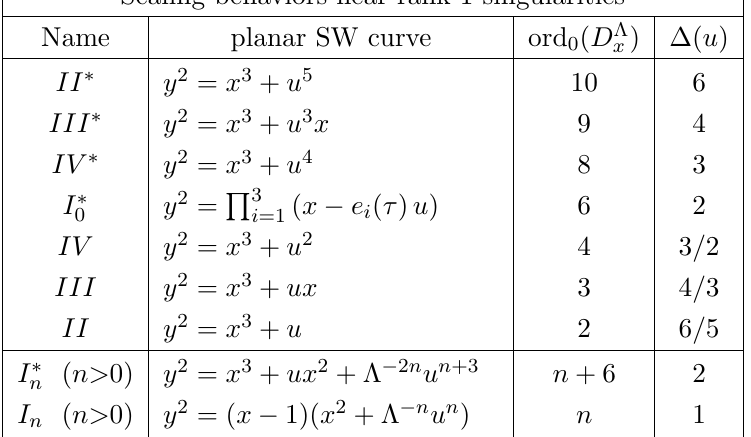
Table 1 . Scaling forms of rank 1 planar special Kahler singularities, labeled by their Kodaira type (column 1), a representative family of elliptic curves with singularity at u = 0 (column 2), order of vanishing of the discriminant of the curve at u = 0 (column 3), mass dimension of u (column 4), a representative of the SL (2 ; Z ) conjugacy class of the monodromy around u = 0 (column 5), the de(cid:12)cit angle of the associated conical geometry (column 6), and the value of the low energy U(1) coupling at the singularity (column 7). The (cid:12)rst seven rows are scale invariant. The last two rows give in(cid:12)nite series of singularities which have a further dimensionful parameter (cid:3) so are not scale invariant; they can be interpreted as IR free theories since (cid:28) 0 = i 1